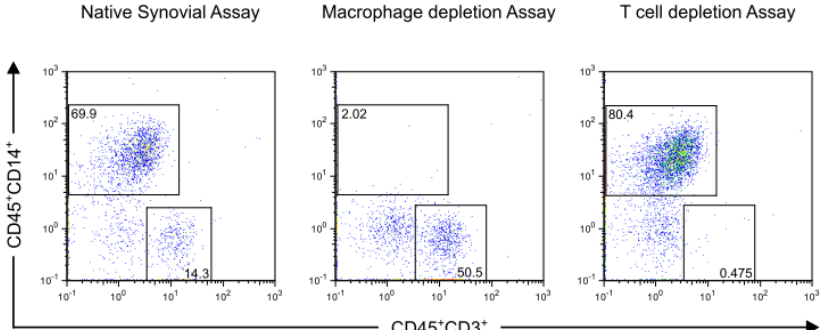
Figure 3. Flow cytometry analyses of synovial membrane from a representative patient with advanced knee OA before and after mononuclear cell depletion are shown. Synovial membrane was enzymatically digested and depletion of CD14 + and CD3 + cells were performed using magnetic activated cell sorting. Samples of native synovial assay and depletion assays were stained with R-phycoerythrin (PE)-conjugated antibodies against CD45 (Clone: 5B1), fluorescein isothiocyanate (FITC)-conjugated antibodies against CD14 (Clone: M5E2), Allophycocyanin (APC)-conjugated antibodies against CD3 (Clone: HIT3a) and 7-aminoactinomycin D (7-AAD). Alive cells were gated based on their forward- / side-scatter (FSC) profile and their a ffi nity to 7-AAD. Dead cells and cell debris were excluded. Then mononuclear cells were defined by their FSC profile and their surface marker expression as CD45 + CD14 + macrophages and CD45 + CD3 + T cells. The e ff ective depletion of synovial macrophages and T cells is